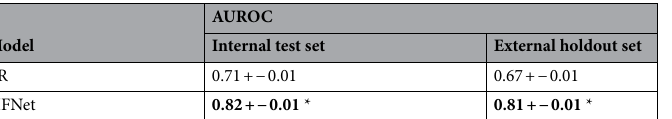
Table 2. Model performance (AUROC) on test data. HFNet significantly outperforms the baseline logistic regression (LR) model. Significant values are in bold. Key: *: p value < 1e − 10.